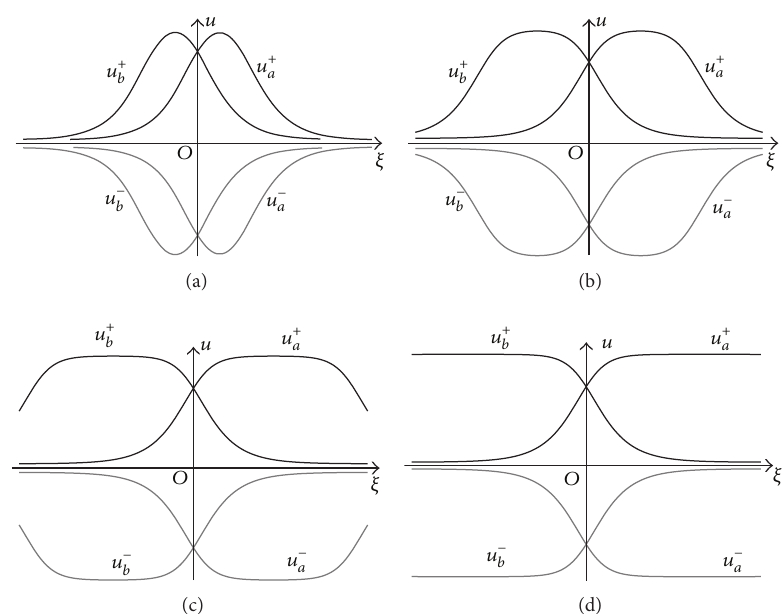
Figure2:Fourlow-kinkwavesarebifurcatedfromfoursymmetricsolitarywaves.Thevaryingprocessforthefiguresof 𝑢 ± 𝑎 and 𝑢 ± 𝑏 when 𝜆 > 0 , − 4𝛼 (𝑎,𝑏) ∈ 𝐴 𝑏 → −(5𝑎 2 /48𝑐)+0 ,where 𝜆 = 50 , 𝛾 = 𝛿 = 𝑐 = 𝑎 = 1 ,and(a) 𝑏 = −(5𝑎 2 /48𝑐)+10 −2 ,(b) 𝑏 = −(5𝑎 2 /48𝑐)+10 −4 , 𝜆 ̸= √𝛽 2 1 , 2 ,and 1 (c) 𝑏 = −(5𝑎 2 /48𝑐) + 10 −6 , and (d) 𝑏 = −(5𝑎 2 /48𝑐) + 10 −9 .